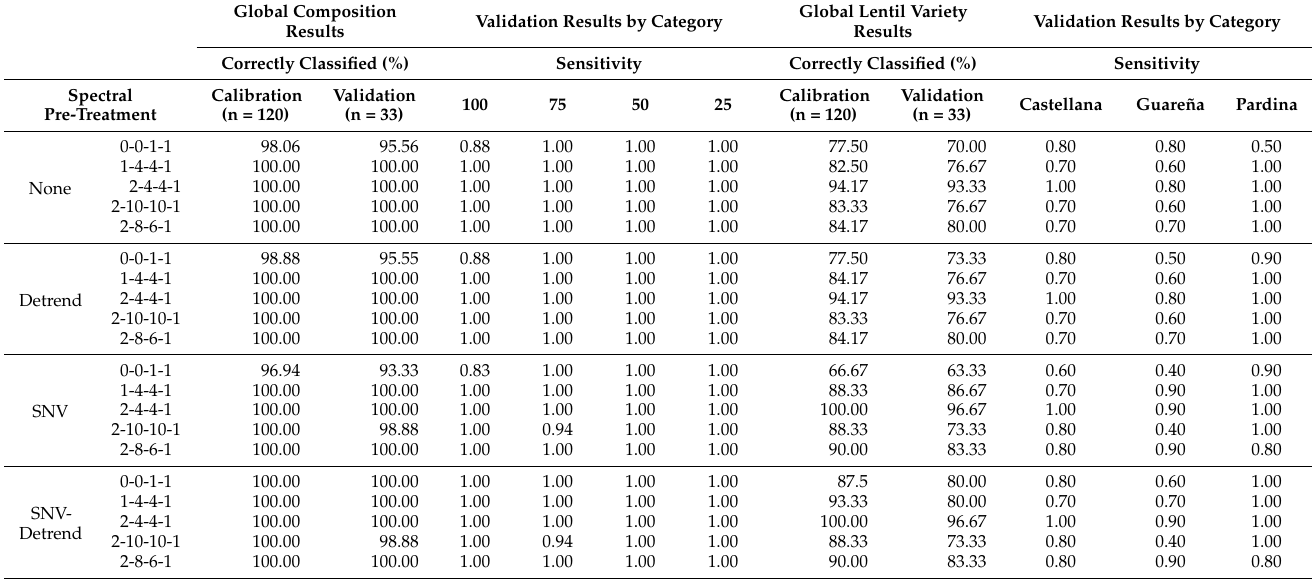
Table 2. Results of the classification of the flours according to the percentage of lentil flour present, based on the mathematical pre-treatments applied to the NIR spectra that provided the best